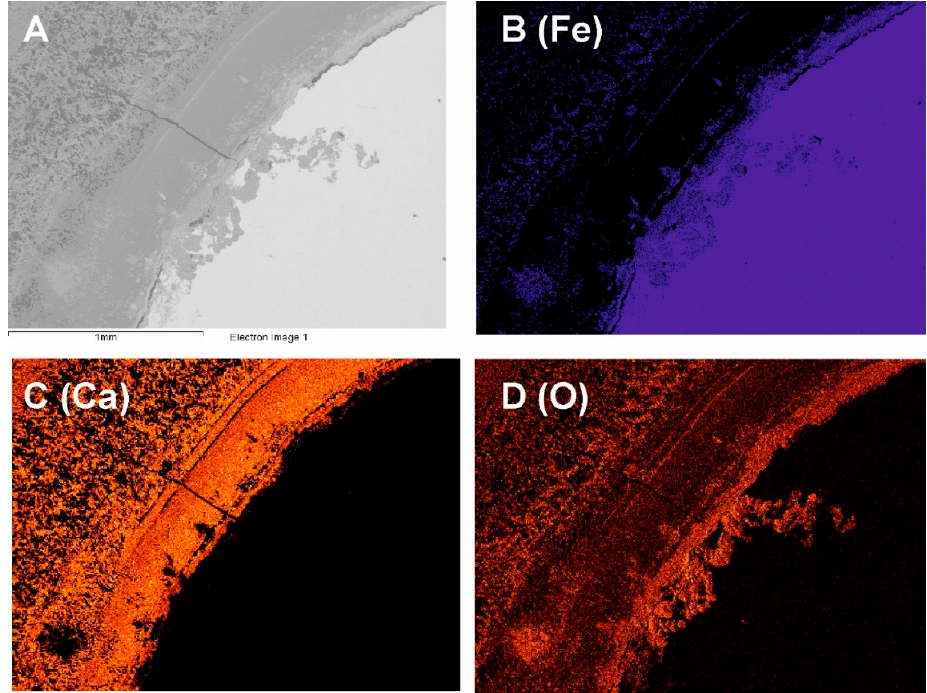
Figure 5. ( A ) Back-Scattered Electron Image (BSEI) of the contact between iron nodule and the Fe-rich laminated travertine; ( B – D ) false color BSEI results of mapping, displaying the distribution of Fe ( purple ), Ca ( orange ) and O ( red ).